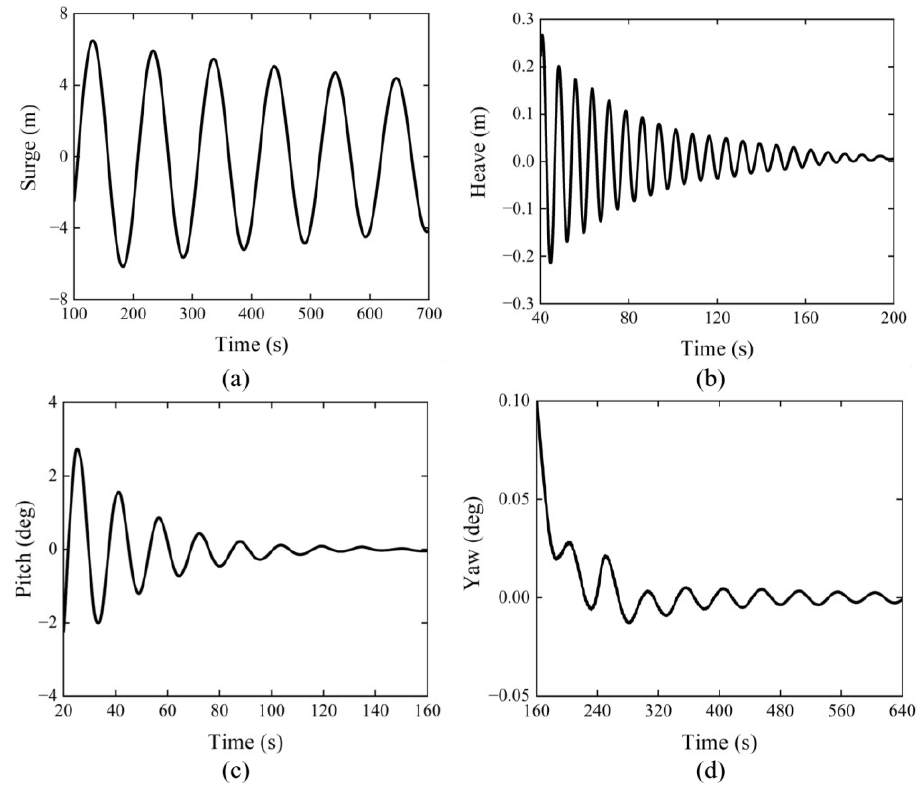
Figure 9. Platform response time series of ( a ) surge, ( b ) heave, ( c ) pitch, and ( d ) yaw in decay tests.